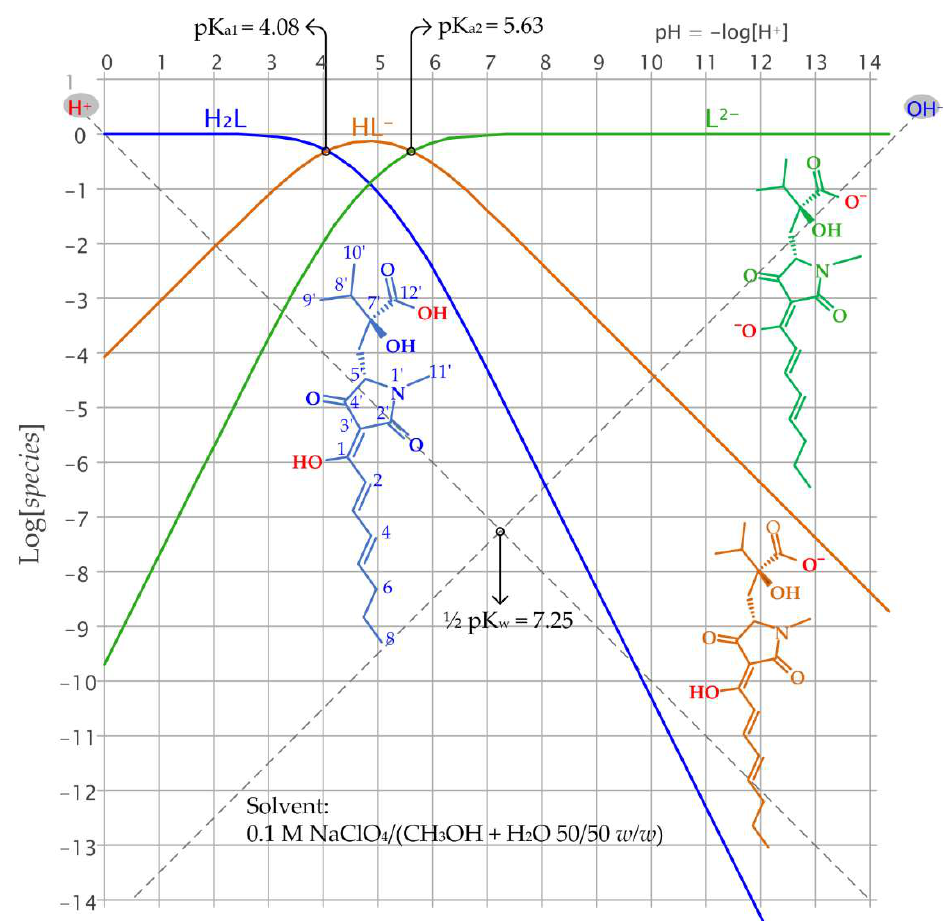
Figure 1. Logarithmic acid-base diagram of harzianic acid (H 2 L) at a conventional analytical concentration of 1 M. Reported dissociation constants of harzianic acid ( K a1 = 10 −4.08 and K a2 = 10 −5.63 ) and the ionic product of water ( K w = 10 −14.5 ) were determined at 25 °C in the mixed solvent 0.1 M NaClO 4 /(CH 3 OH + H 2 O 50/50 w / w ) [29]. Inserts: structures of harzianic acid (H 2 L) and its dissociation products (HL − and L 2− ).